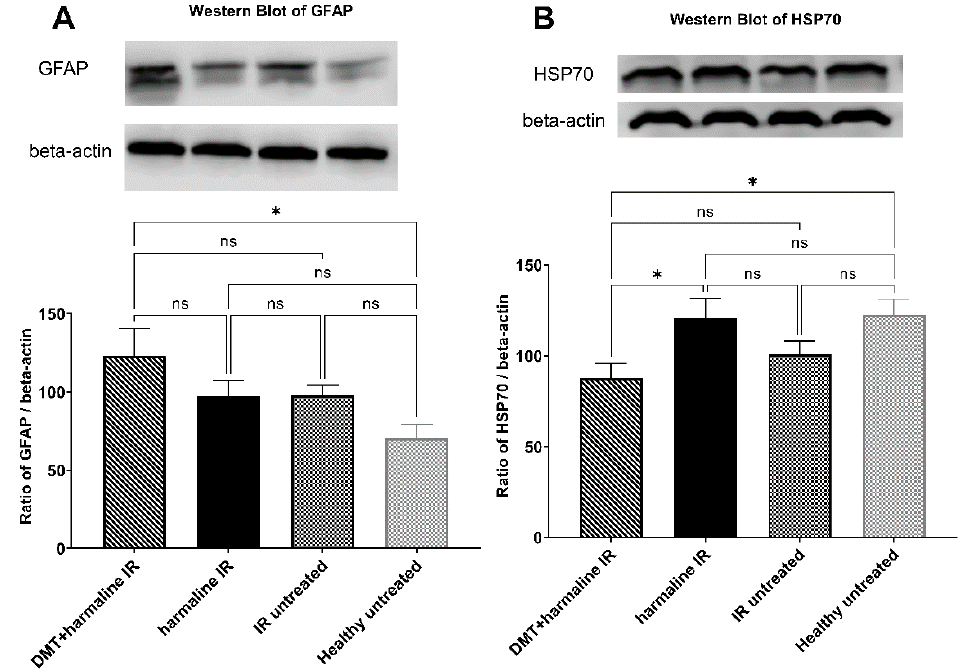
Figure 3. Western blot results. ( A ): Expression levels of Glial fibrillary acidic protein (GFAP) in the different groups. ( B ): Expression levels of heat shock protein 70 (HSP70) in the different groups. All results are plotted as mean percentages + SEM. ns = non-significant; * = p < 0.05.